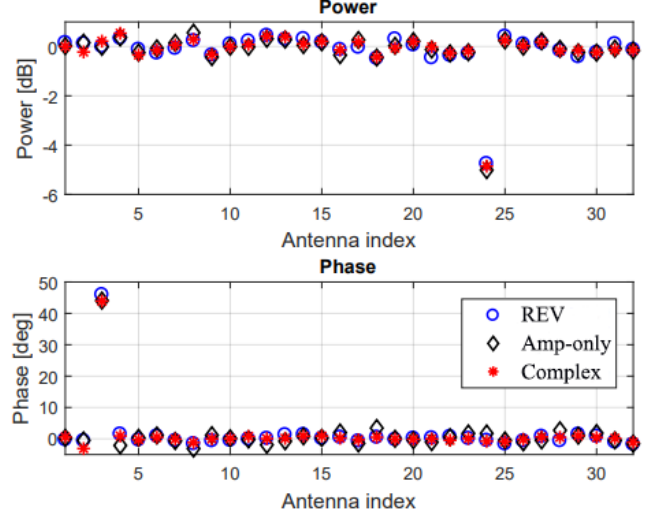
Figure 11. Array calibration results based on three methods with scattering parameters obtained via geometry configuration ( R = 5.85 m).